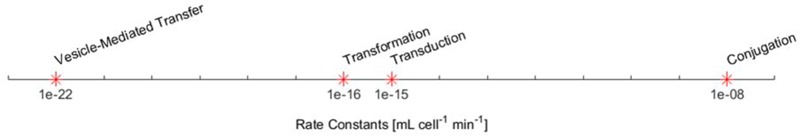
The derived maximum rate constants for the four HGT mechanisms.